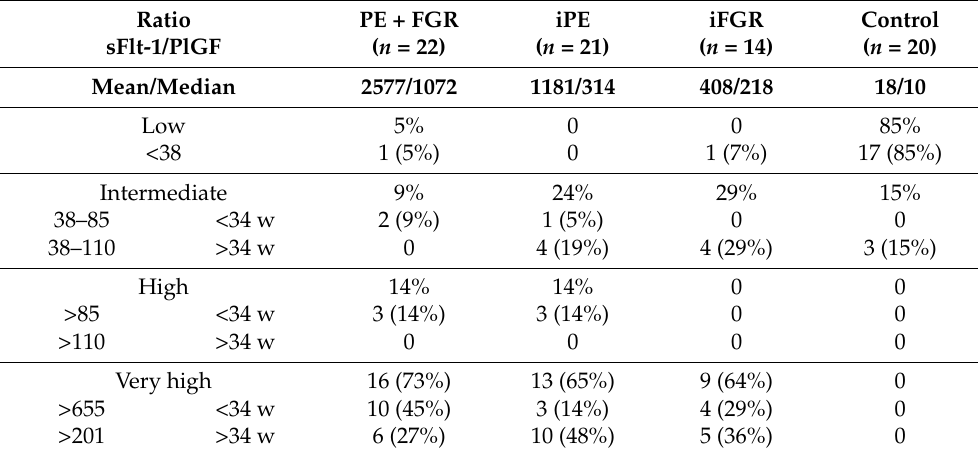
Table 6. Distribution of the sFlt-1/PlGF ratio in each study subgroup in the low, intermediate, high or very high risk groups according to the currently recomended cutoff values.